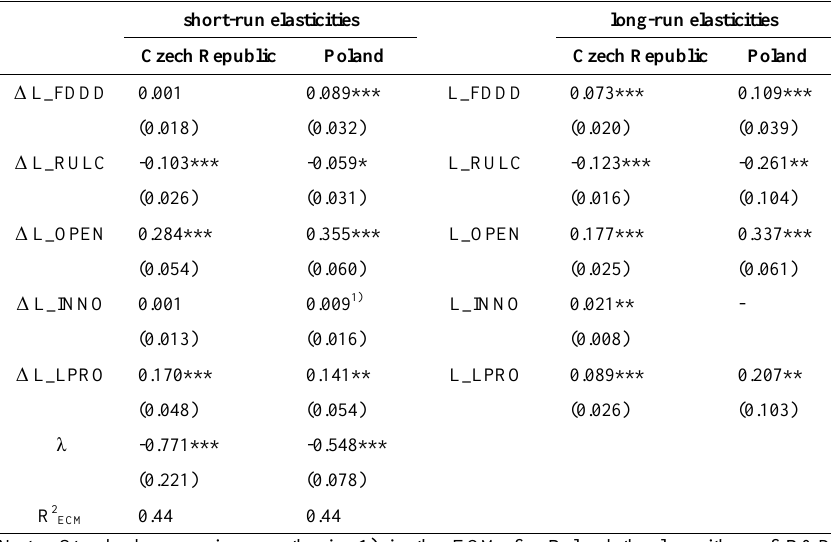
Table 3. Czech and Polish shared model (with relative demand variable) –